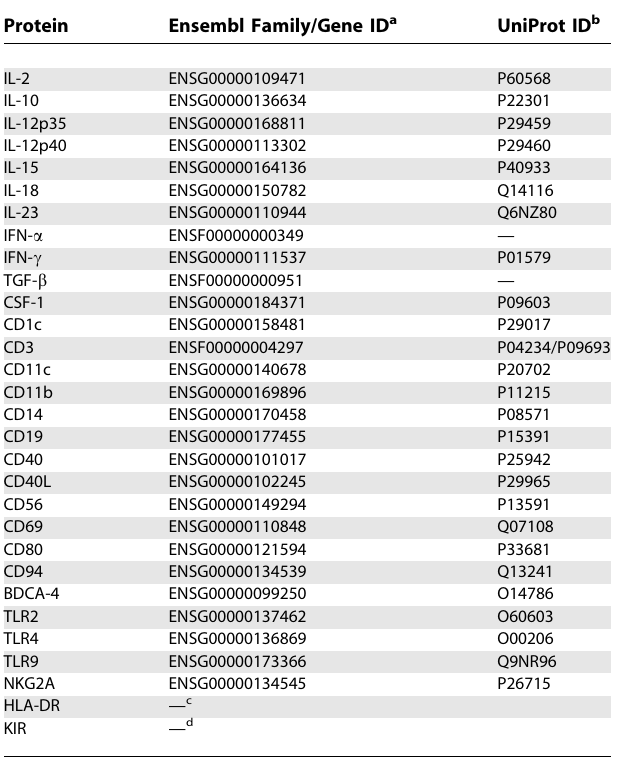
Table 1. Accession Numbers for Genes and Proteins